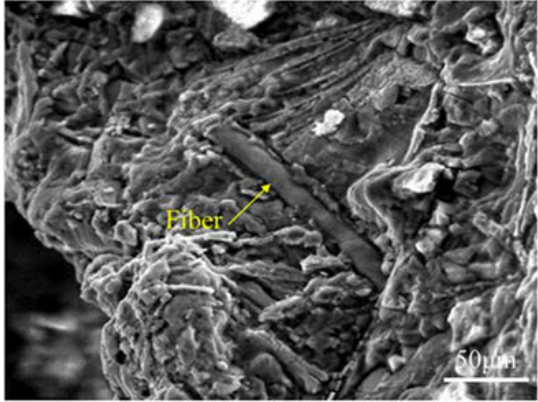
Figure 10. Line scanning across BF, interfacial zone, and the matrix.